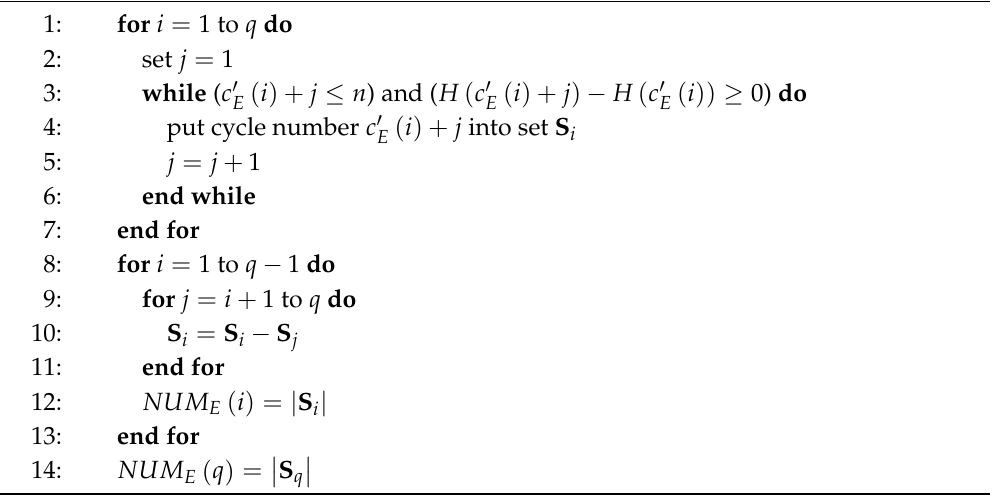
Algorithm 1. Extraction of regeneration region sets and regeneration cycle number